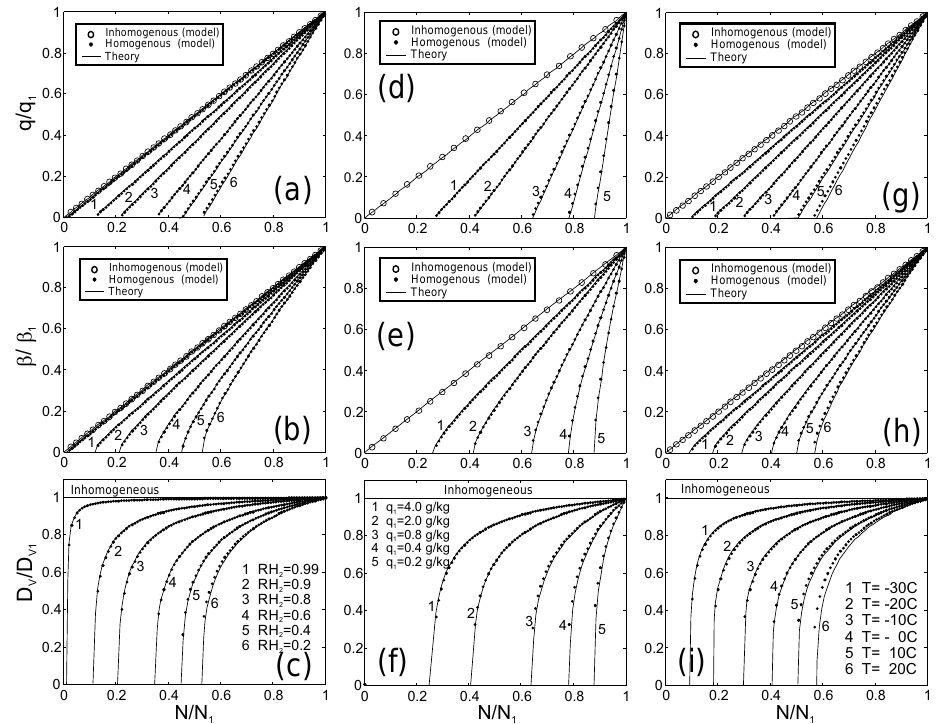
Figure 5. Dependence of normalized liquid water mixing ratio q/q 1 (a, d, g) , extinction coefficient β/β 1 (b, e, h) and mean volume diameter D v /D v1 (c, f, i) vs. normalized number concentration N/N 1 for various humidity of the entrained air (a, b, c) , for various liquid water mixing ratios (d, e, f) and for various temperatures (g, h, i) . The calculations were performed for the following initial conditions: H = 1000m, D 1 = 20µm; for (a – c) T 1 = T 2 = 0 ◦ C, N 1 = 500cm − 3 ; (d – f) T 1 = T 2 = 0 ◦ C, RH 2 = 0.5; (g – i) T 1 = T 2 = T , N 1 = 500cm − 3 , RH 2 = 0 .